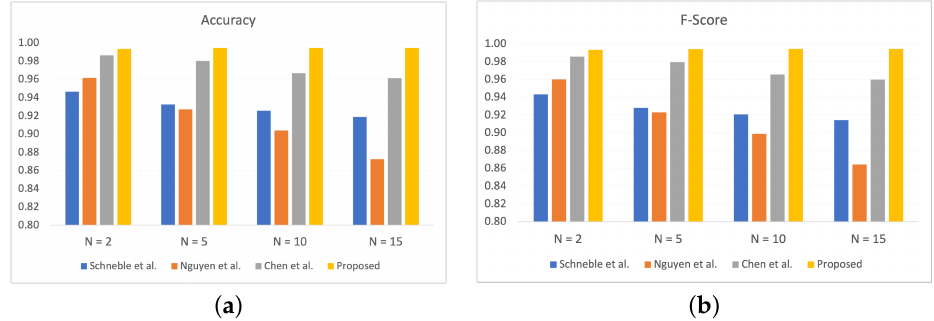
Figure 6. Performance comparison of FLDID with state-of-the-art approaches with different number of edge devices for R = 10: ( a ) N = 2, ( b ) N = 5.